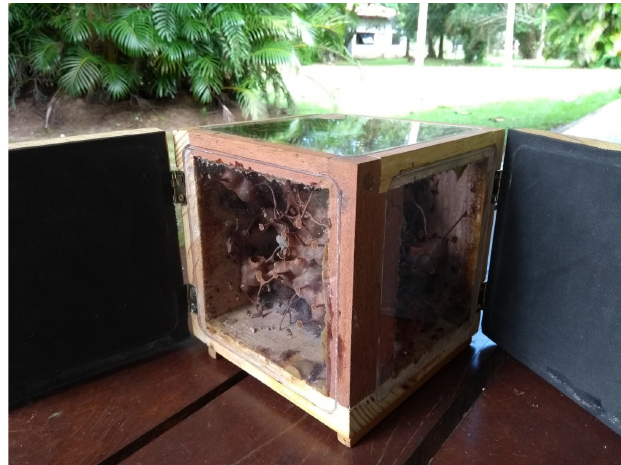
Fig 4 . Two Movable Walls Version (Photo by Celso